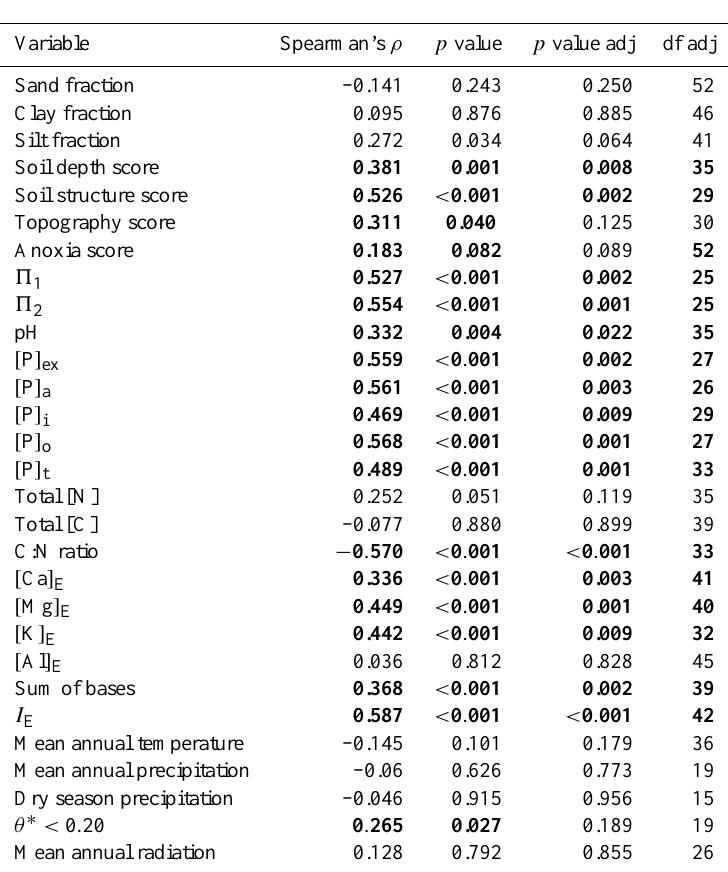
Table 5. Spearman’s ρ for relationships between stand-level turnover rates and a range of soil and climate predictors. Probabilities ( p ) are given with and without adjustment (adj) for degrees of freedom (df) according to Dutillieul (1993). Abbreviations used: 5 1 and 5 2 – first and second indices of soil physical conditions (Sect. 2.2); [ P ] ex , [ P ] a , [ P ] i , [ P ] o , [ P ] t – extractable, available, inorganic, organic and total soil phosphorus pools; [ Ca ] E , [ Mg ] E , [ K ] E , [ Al ] E - exchangeable calcium, magnesium, potassium, and aluminium concentrations; I E – effective soil cation exchange capacity; θ ∗ < 0 . 20 – modelled number of months with soil water less than 0.2 of maximum available soil water content. Where p ≤ 0 . 050 values are shown in